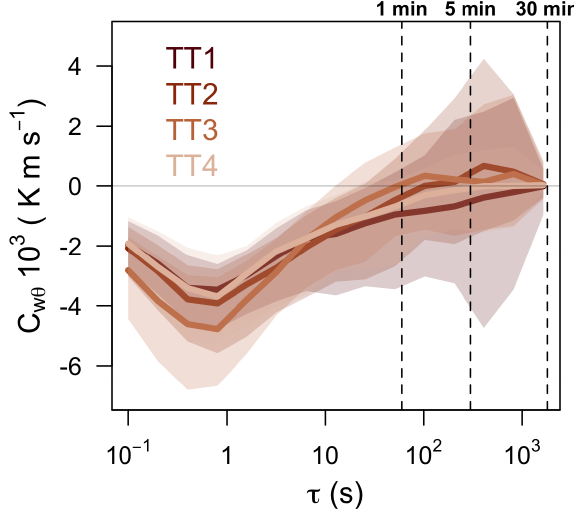
Figure 2. Multi-resolution flux decomposition of buoyancy flux as a function of timescale τ for the four examined stations. Shown are median (full line) and interquantile ranges